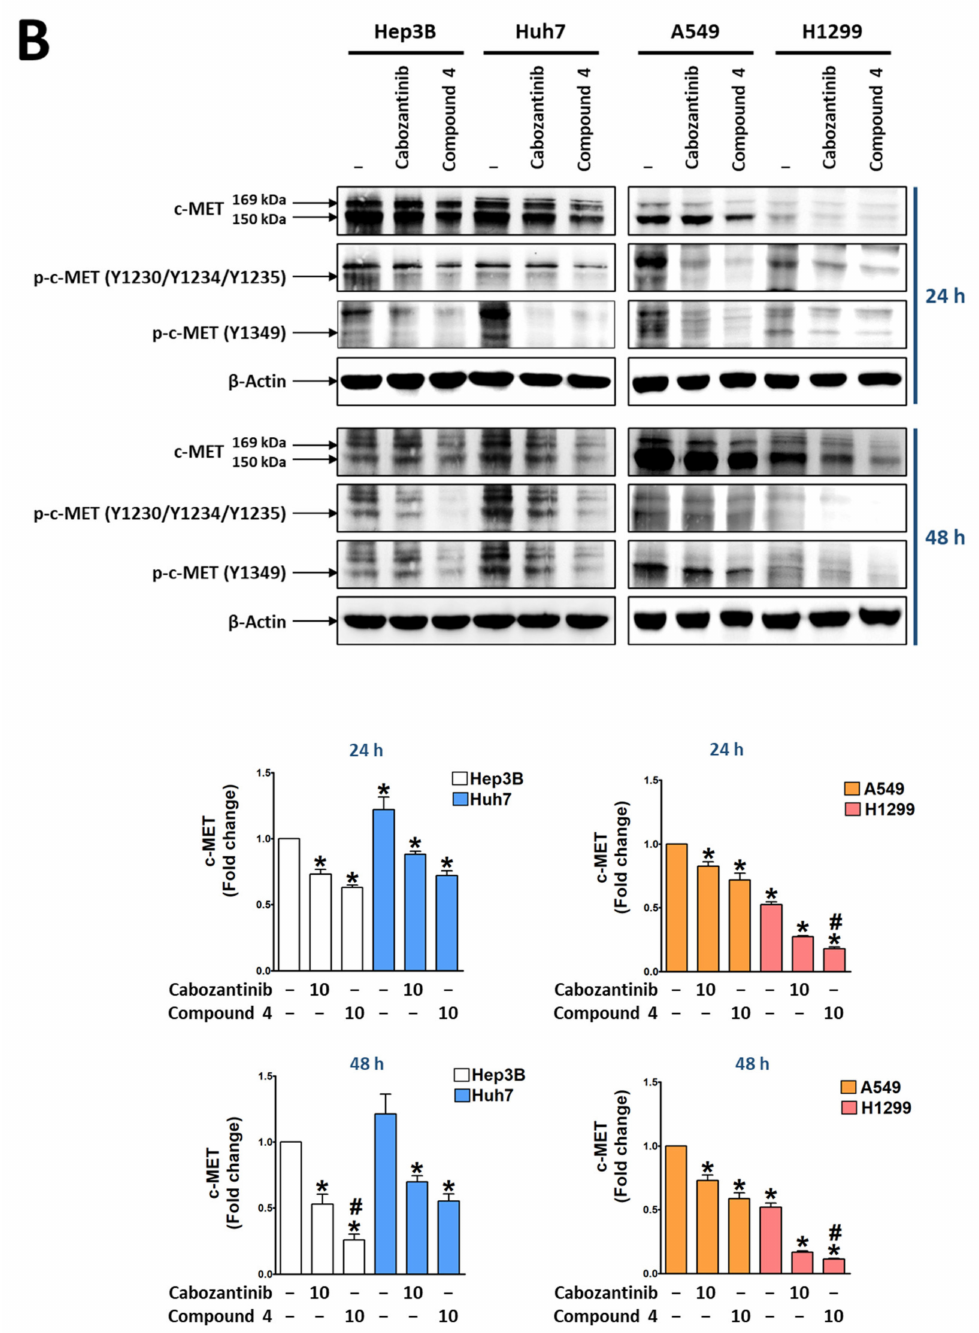
Figure 4. Inhibitory effects of cabozantinib and compound 4 on c -MET expression and activity in HCC and NSCLC cell lines. ( A ) Comparison of the expression level and activity (phosphorylation) of c -MET in Hep3B, Huh7, A549, and H1299 cells. Two bands were detected for c -MET protein, precursor protein (169 kDa), and the biologically active transmembrane β -subunit (150 kDa). Bar graphs represent the mean ± S.E.M. from three independent experiments. * p <0.05, compared to Hep3B. # p < 0.05, compared to Huh7. $ p < 0.05, compared to H1299. ( B ) c -MET expression and activity status in the cells treated with cabozantinib and compound 4 for 24 and 48 h. Bar graphs represent the mean ± S.E.M. from three independent experiments. * p < 0.05, compared to vehicle-treated Hep3B or A549 cells. # p < 0.05, compared to each cell line treated with